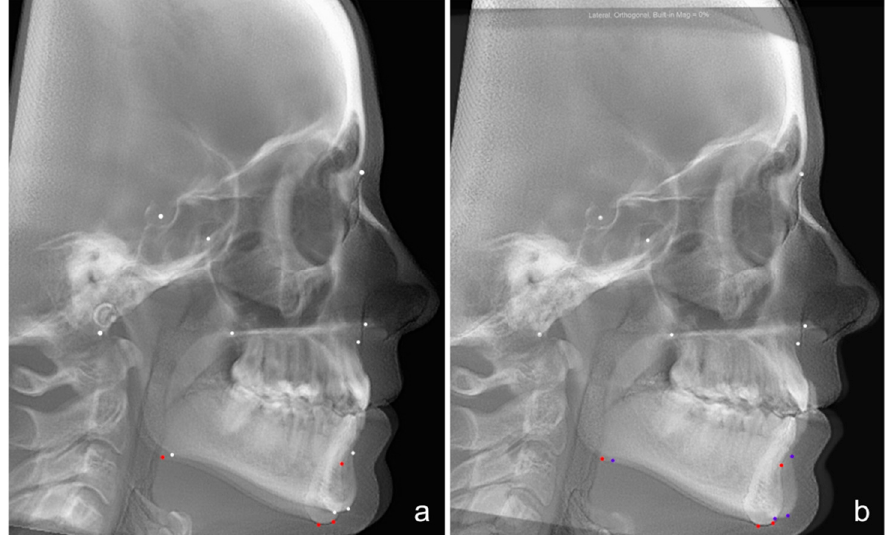
Figure 3. Representative superimpositions of presplint (T1) vs. postsplint (T2) ( a ) and postsplint (T2) vs. postintrusion (T3) ( b ) lateral cephalograms. Following splint wear ( a ), there was a significant increase in lower facial height and significant decrease in facial axis angle, which in turn increased ANB angle. After intrusion ( b ), mandible exhibited counterclockwise rotation, which was confirmed by decreased lower facial height, increased OB and facial axis angle and decreases in ANB. Table 5. Frequency of osseous changes before and after therapy (* p <